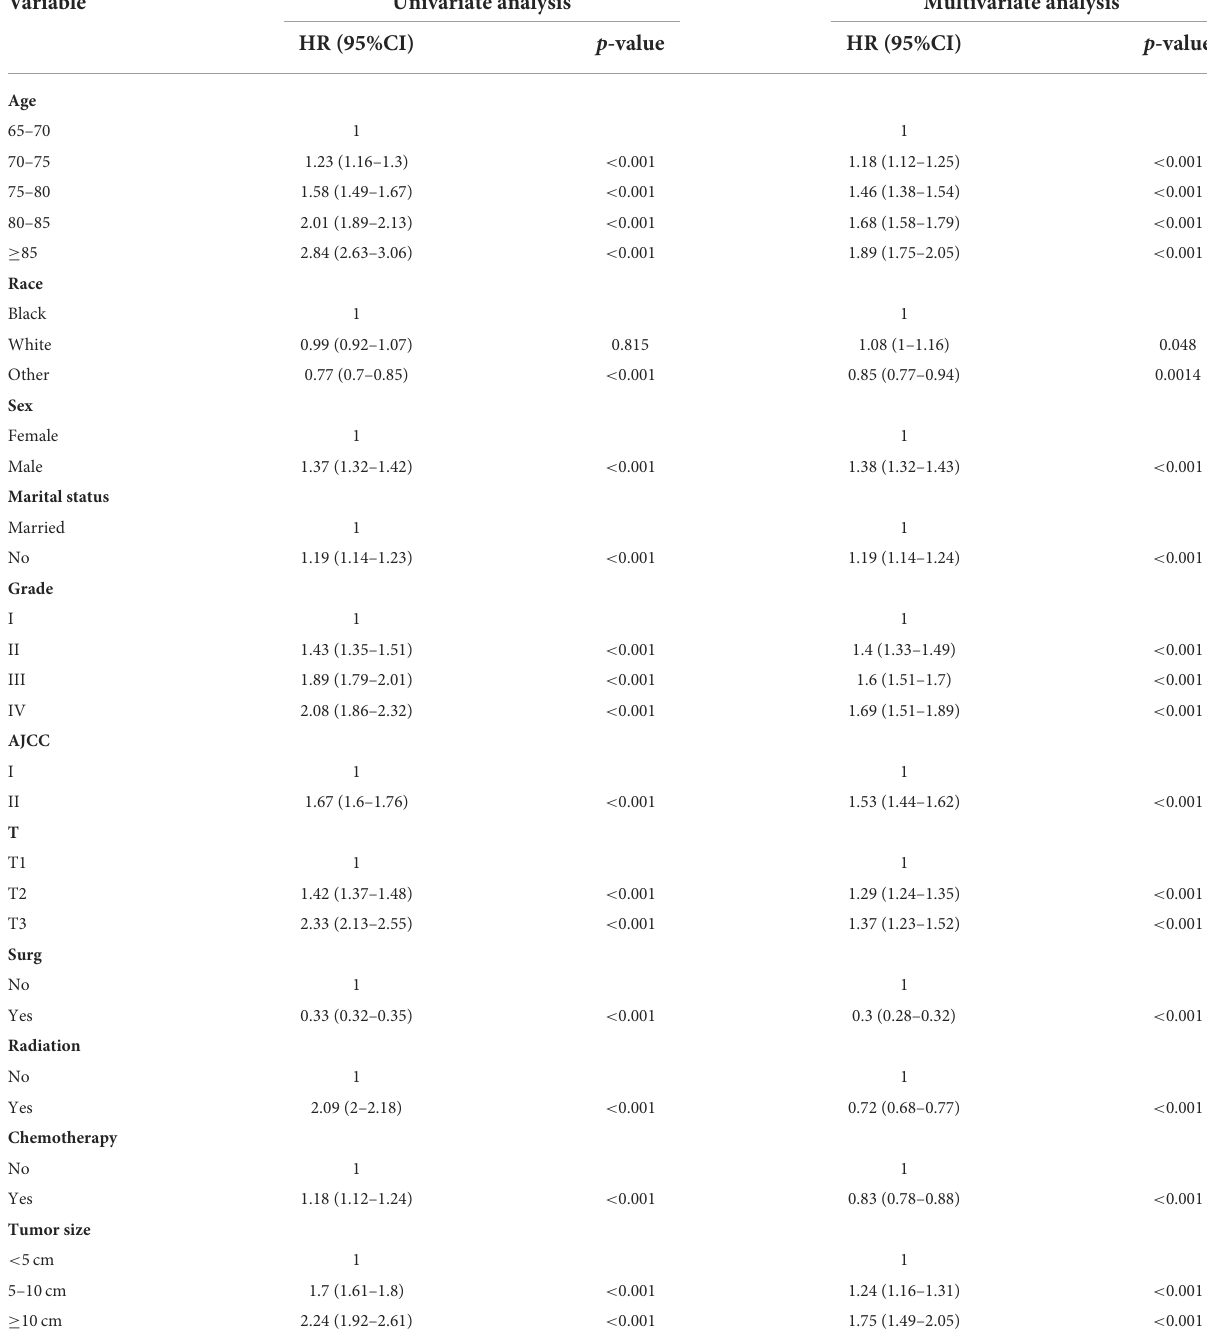
TABLE 3 Univariate and multivariate analyses of OS and CSS in training set. Variable Univariate analysis Multivariate